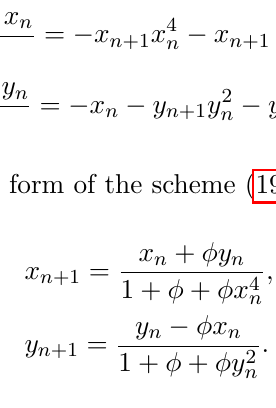
The trivial equilibrium point E ∗ = (0 , 0) is also a non-hyperbolic equilibrium point of the scheme (19). So, the classical Lyapunov’s indirect method fails to conclude the stability of E ∗ . However, by the new theorem 4, we can show that E ∗ is a asymptotically stable equilibrium point of the NSFD scheme (19). Figures 6-8 sketch numeri- cal solutions generated by the NSFD scheme (19) with three different step sizes. In these figures, each blue curve represents a phase plane corre- sponding to a specific initial data, the red circle represents the position of the stable equilibrium point and the yellow arrows show the evolution of the model. Clearly, the stability of the system (18) is